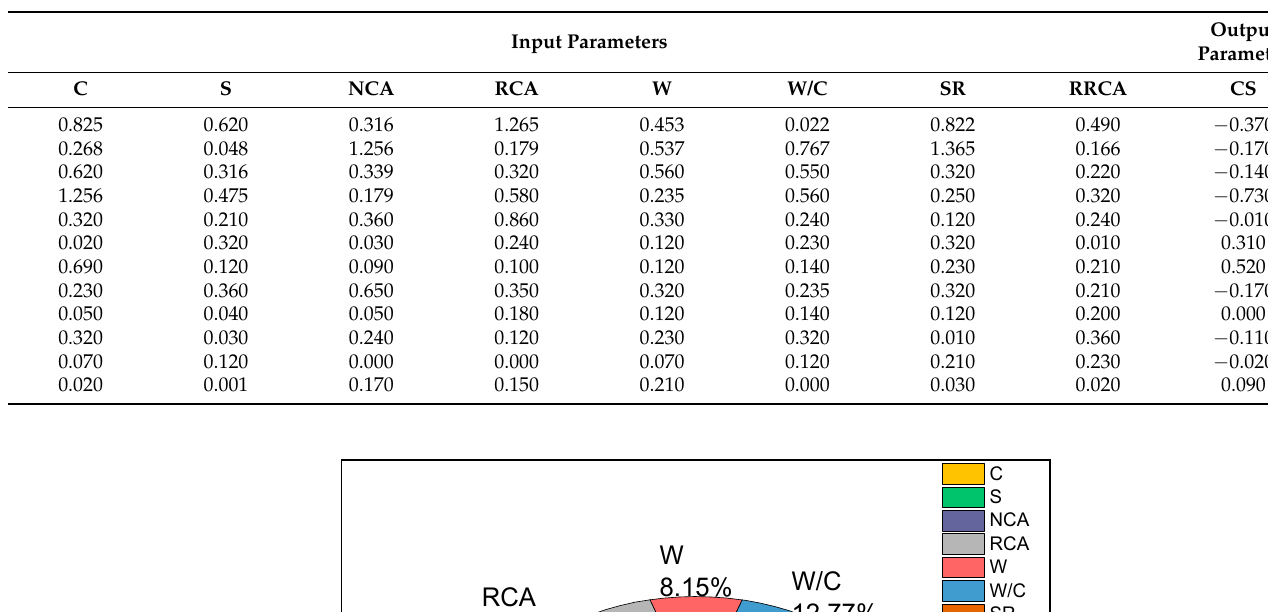
Table 9. Connection weights obtained by optimal BPNN.